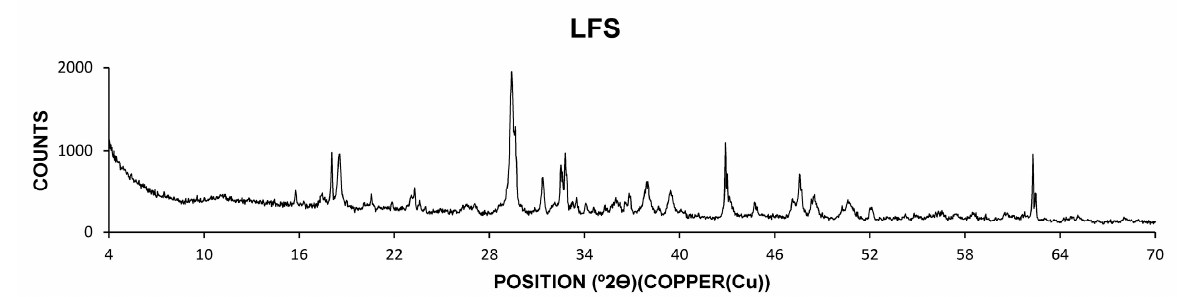
Figure 1. Results of X-ray diffraction of ladle furnace slag.